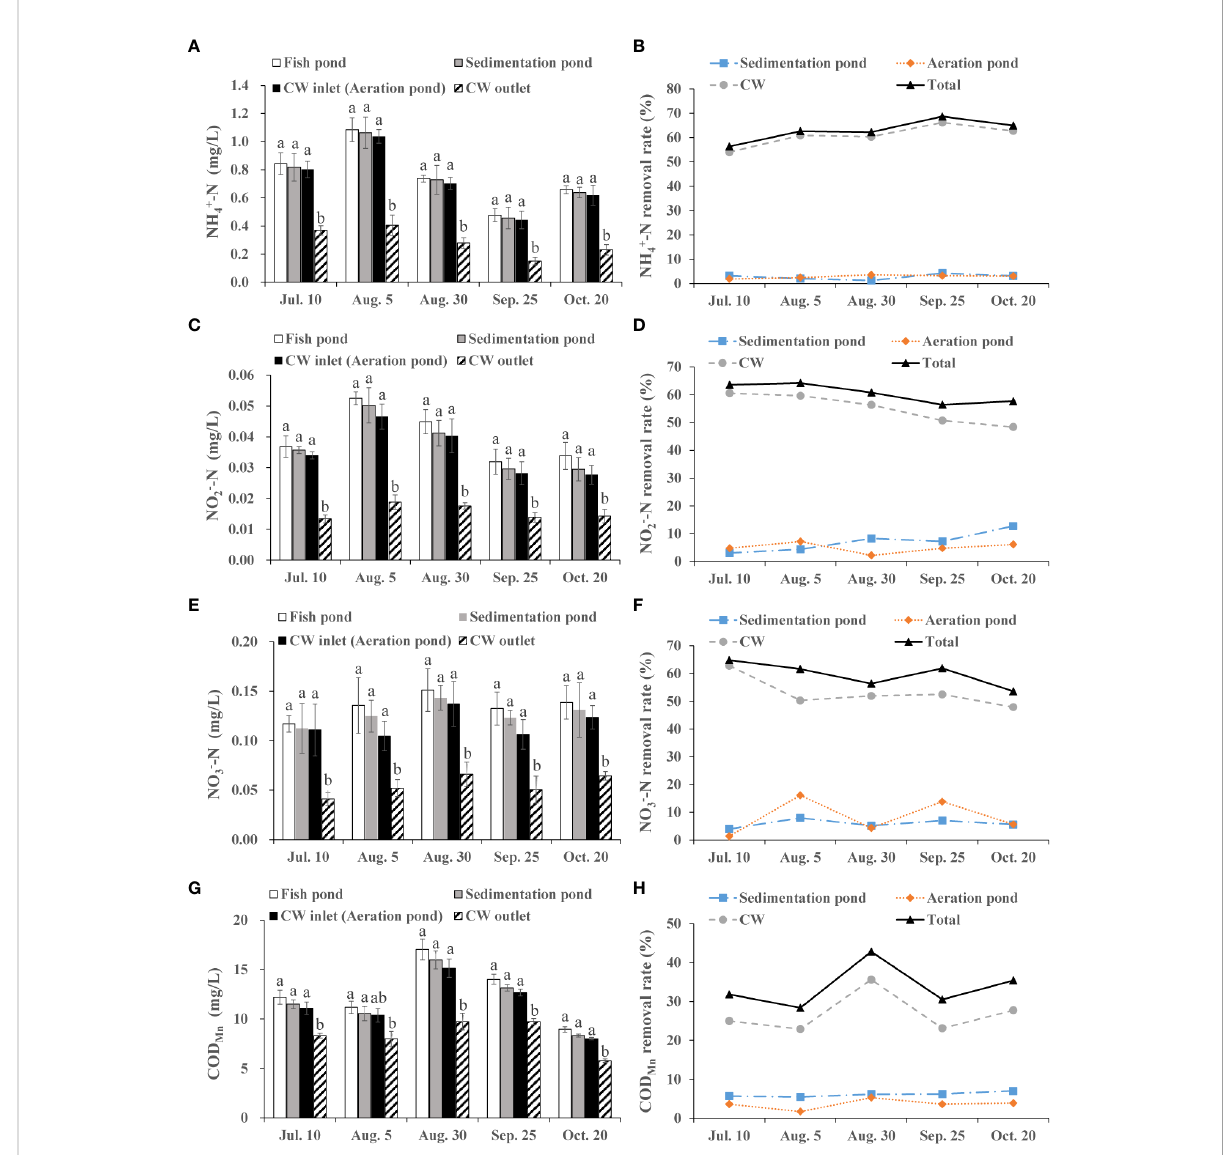
FIGURE 2 Removal ef fi ciency of integrated CW system on NH 4+ -N, NO 3- -N, NO 2- -N and COD Mn during the fi sh farming period. (A) NH 4+ -N value in the fi sh pond, sedimentation pond, CW inlet (aeration pond) and CW outlet. (B) NH + -N removal rate of the sedimentation pond, aeration pond and 4 CW. (C) NO 2- -N value in the fi sh pond, sedimentation pond, CW inlet (aeration pond) and CW outlet. (D) NO 2- -N removal rate of the sedimentation pond, aeration pond and CW. (E) NO 3- -N value in the fi sh pond, sedimentation pond, CW inlet (aeration pond) and CW outlet. (F) NO 3- -N removal rate of the sedimentation pond, aeration pond and CW. (G) COD Mn value in the fi sh pond, sedimentation pond, CW inlet (aeration pond) and CW outlet. (H) COD Mn removal rate of the sedimentation pond, aeration pond and CW. The value is expressed as mean ± SE (n = 5). Different small letters in bar graph indicate signi fi cant difference ( p < 0.05) among fi sh pond, sedimentation pond, CW inlet (aeration pond) and CW